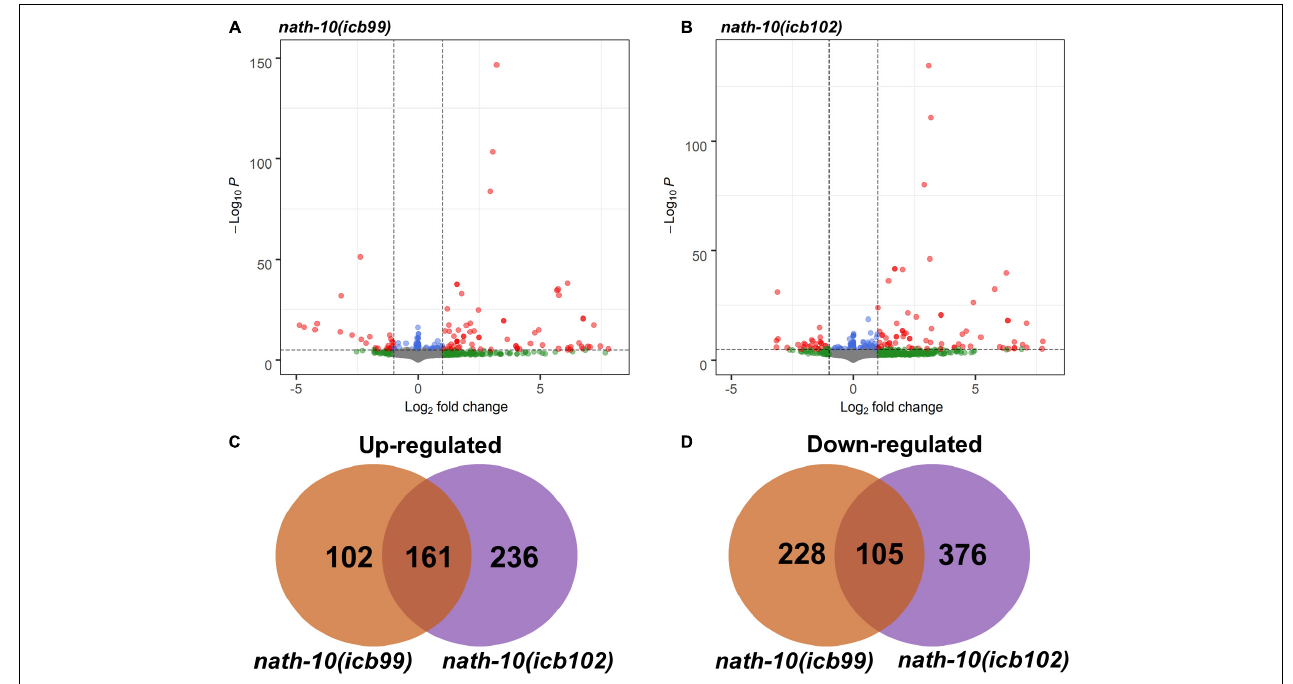
FIGURE 3 | RNA-seq analysis of nath-10 mutants reveals differentially expressed genes. (A,B) Volcano plots displaying summary of nath-10 ( icb99) and nath-10(icb102) changes in comparison to N2 animals. Green dots indicate > 1.2-fold change, blue dots < 0.01 adjusted p -value and red dots > 1.2-fold change and < 0.01 adjusted p -value. (C) Overlap of significantly differentially upregulated genes in nath-10 ( icb99) and nath-10(icb102) alleles. (D) Overlap of significantly differentially downregulated genes in nath-10 ( icb99) and nath-10(icb102)